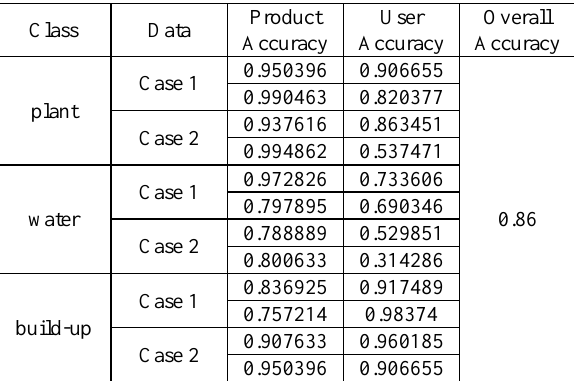
Table 4 Accuracy of Multi-scale CART Tree